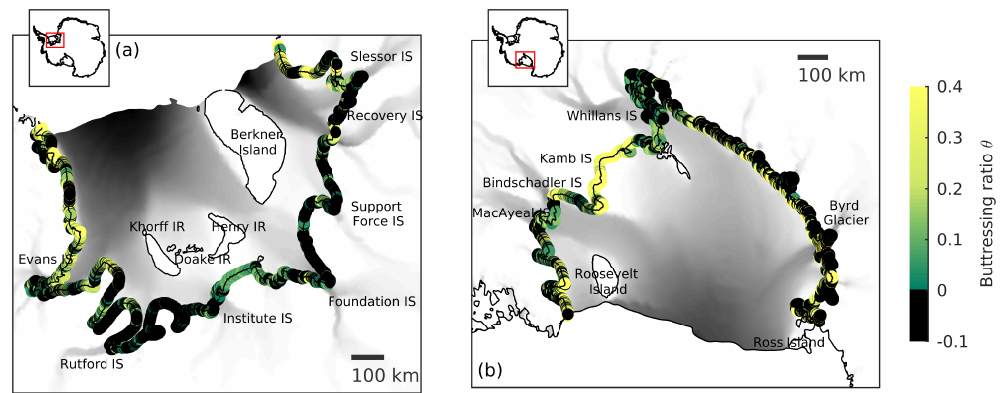
Figure 2. Buttressing ratio θ 1 along the grounding lines of Filchner–Ronne Ice Shelf (a) and Ross Ice Shelf (b) . Insets indicate the ice shelves’ locations in Antarctica. Regions where the grounding line is over-buttressed, that is, θ ≤ 0, are displayed in black. Modelled speed is plotted in grey ranging up to 1500ma − 1 . Grounding line and ice front locations are indicated in black. IS denotes ice streams; IR denotes ice rises or rumples.